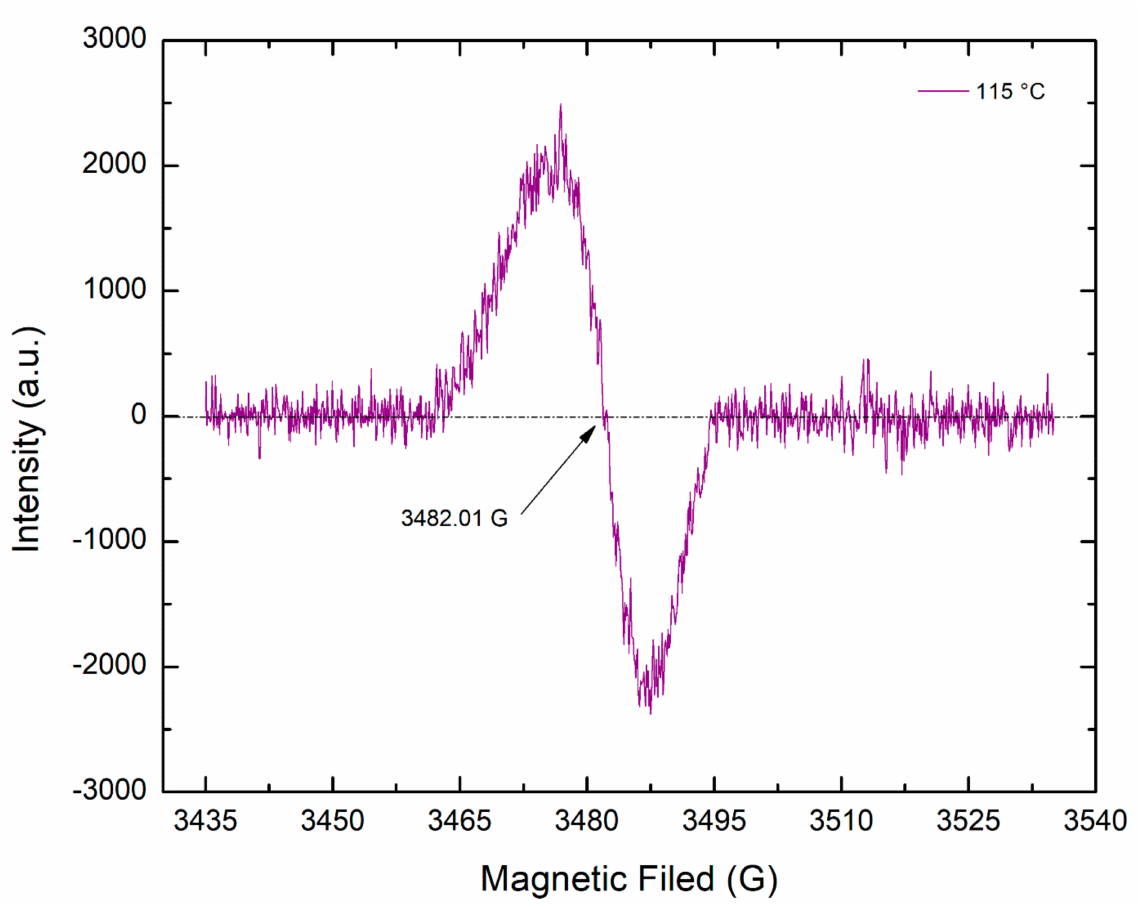
Figure 5. Electron paramagnetic resonance (EPR) spectrum of polyenyl free radicals detected in thermally aged UHMMPE fibers at 115 ◦ C in